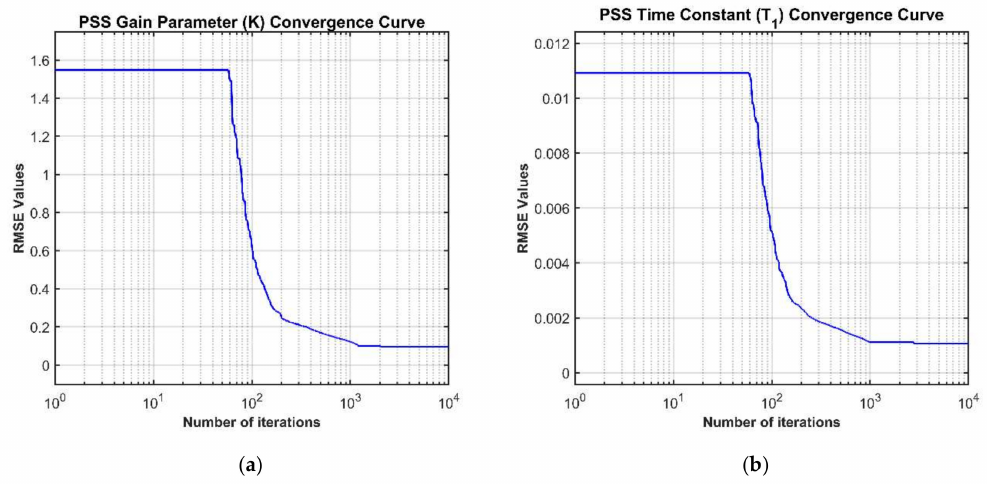
Figure 6. RMSE values convergence curves for the PSS key parameters of the first network test datasets;